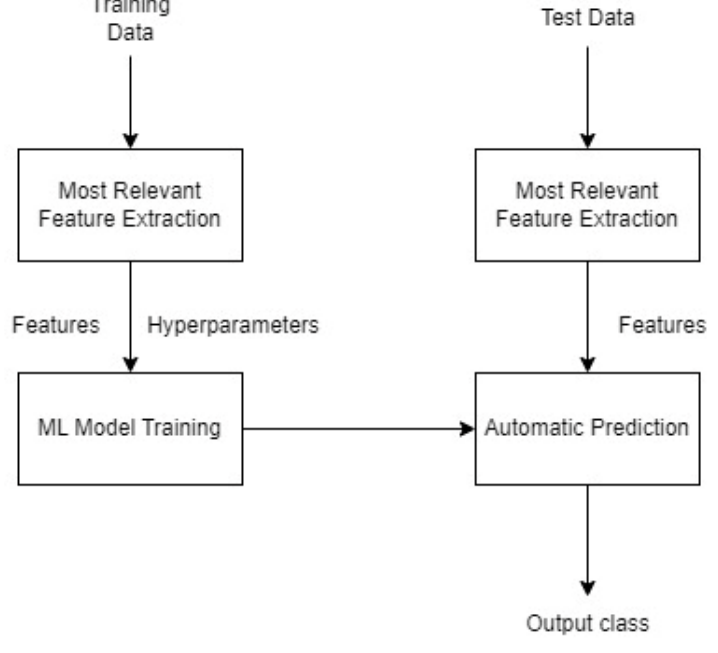
Figure 4. ML Model Development Pipeline.